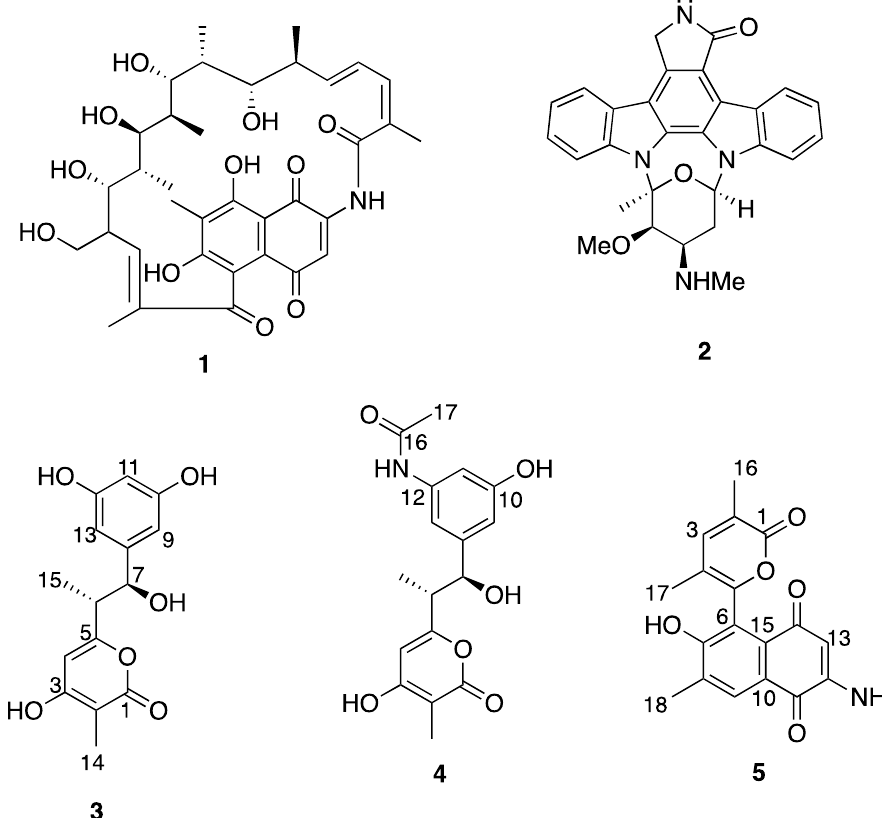
Figure 1. Chemical structures of compounds 1 to 5 .